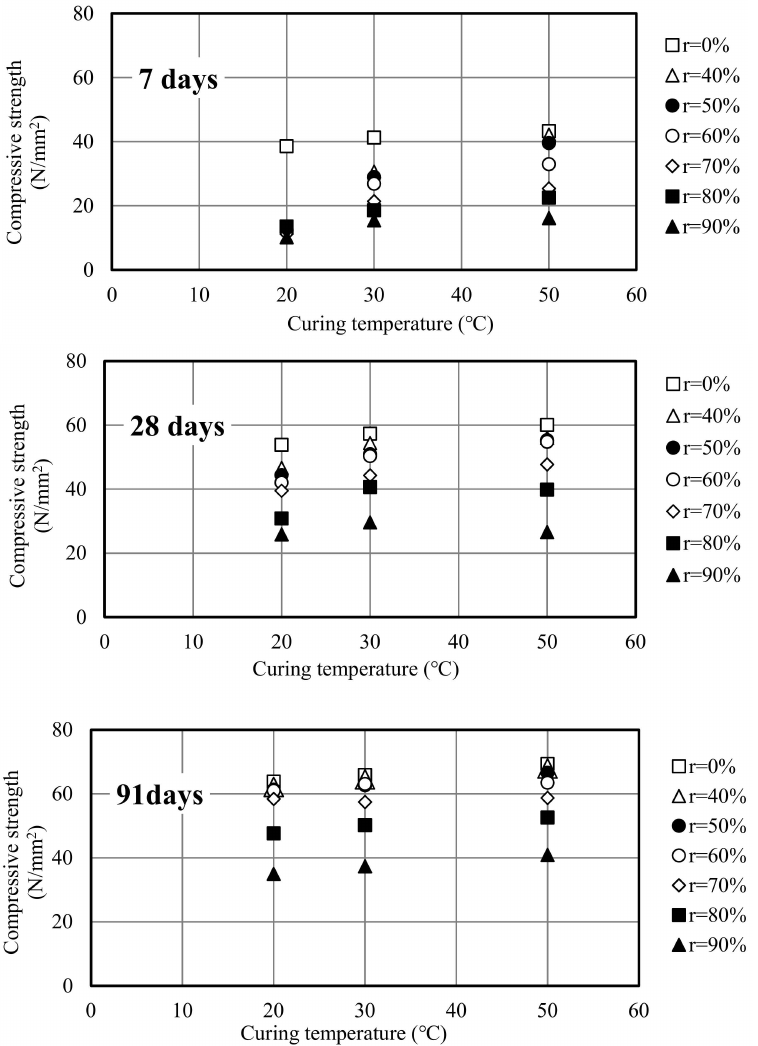
Figure 4. Relationship between curing temperature and compressive strength at di ff erent curing